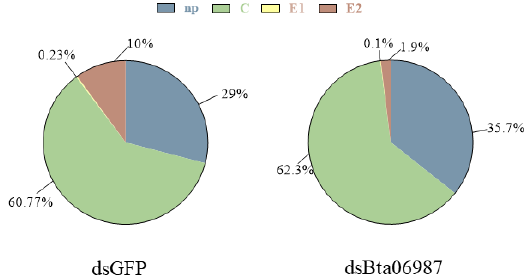
Figure 7. Mean percentage of the EPG waveforms in 8 h feeding. dsGFP: B. tabaci fed with dsRNA of GFP , dsBta06987: B. tabaci fed with dsRNA of Bta06987. The waveform for intercellular stylet pathway (C) and non-probing (np), waveform for salivation into phloem sieve elements (E1), and phloem ingestion (E2).